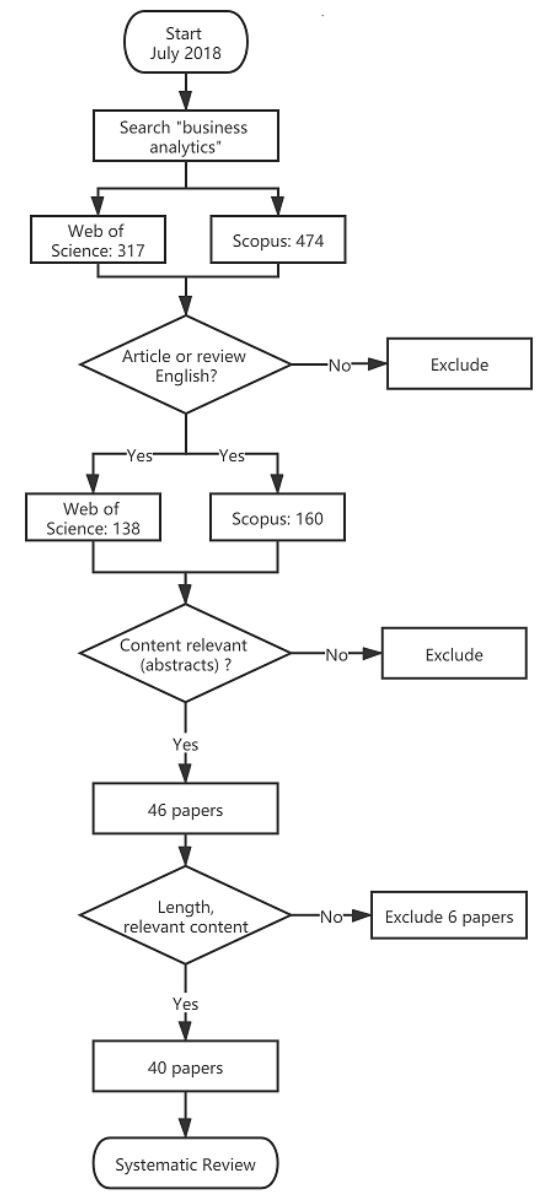
Figure 1. Process of